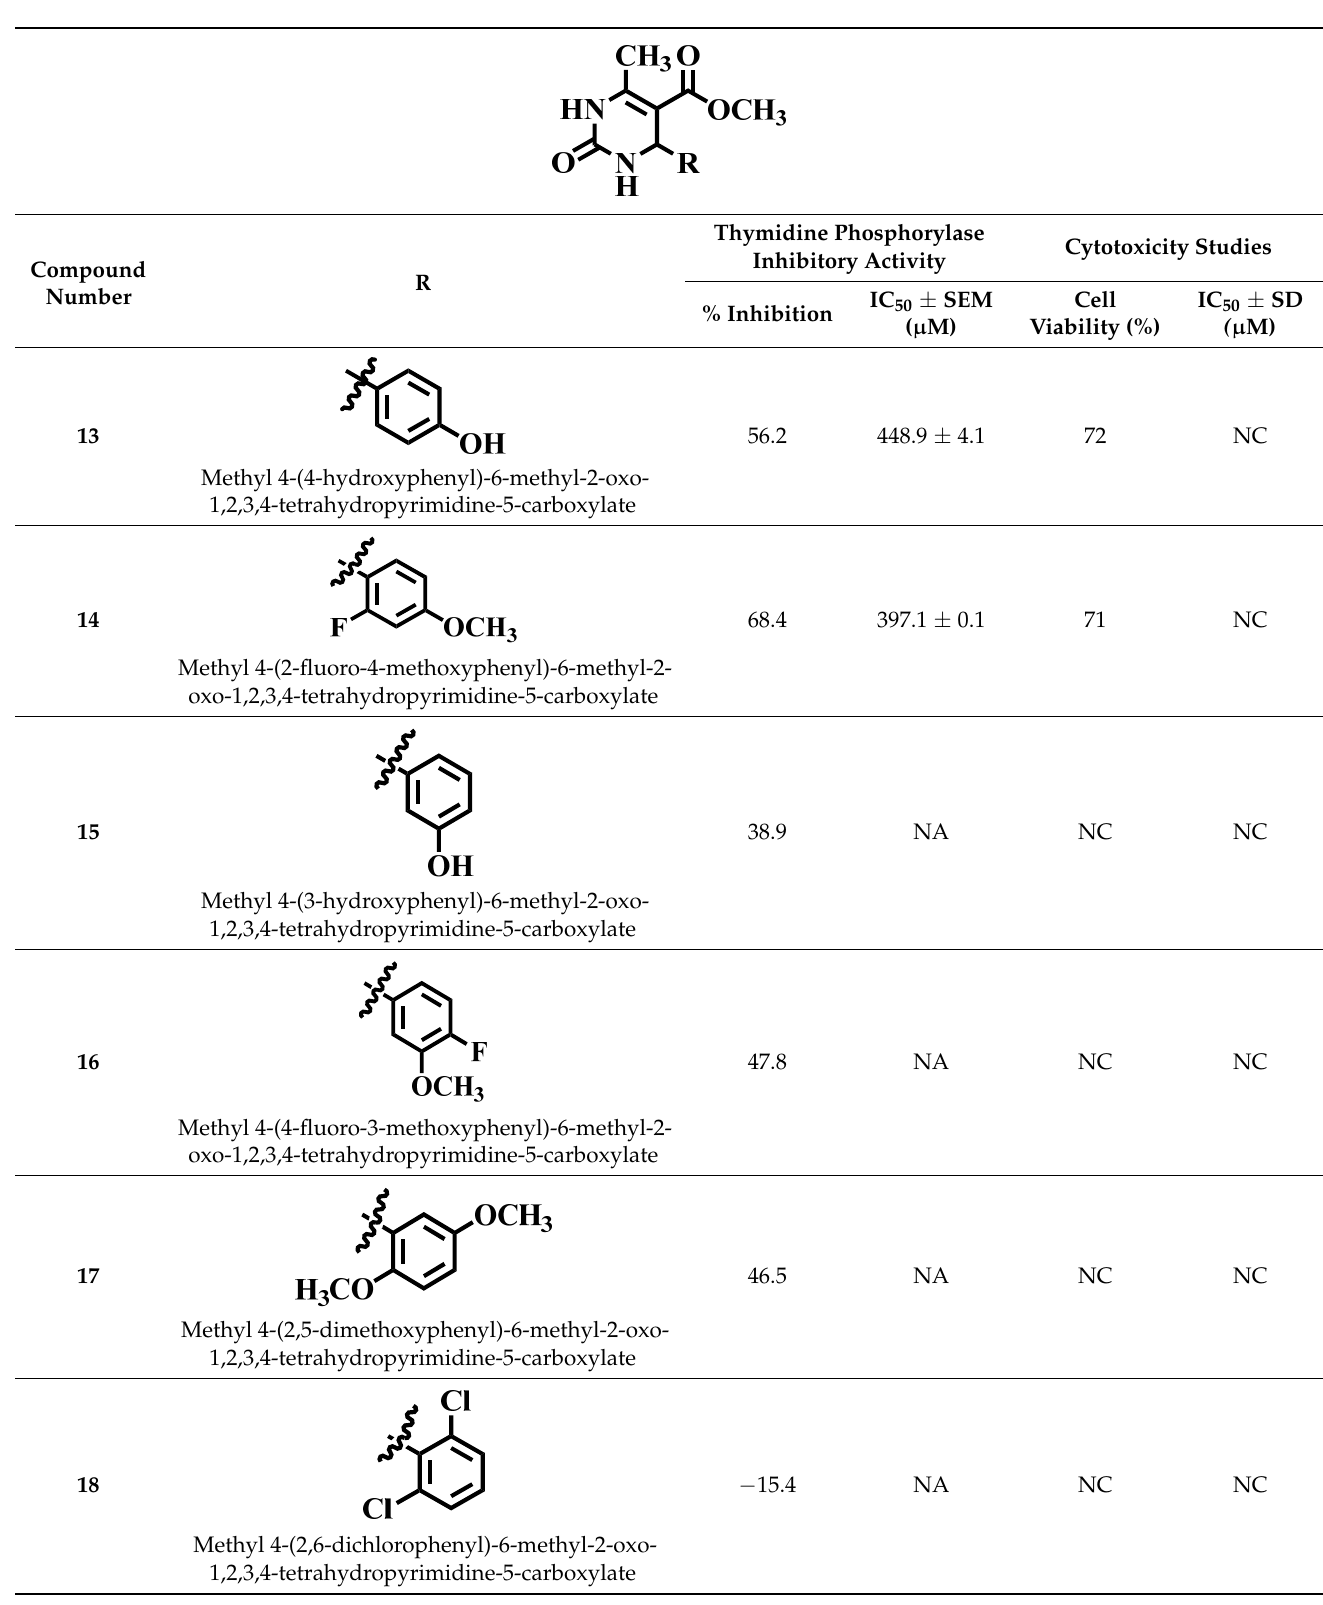
Table 1. Thymidine phosphorylase (TP) inhibitory activity of dihydropyrimidone ( 1 – 40 Table 1. Cont.